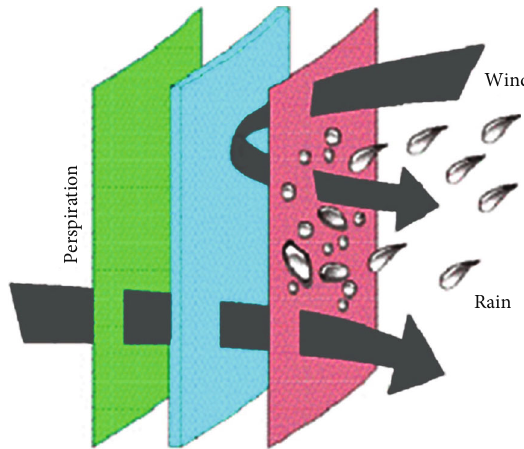
Figure 10: Waterproof breathable